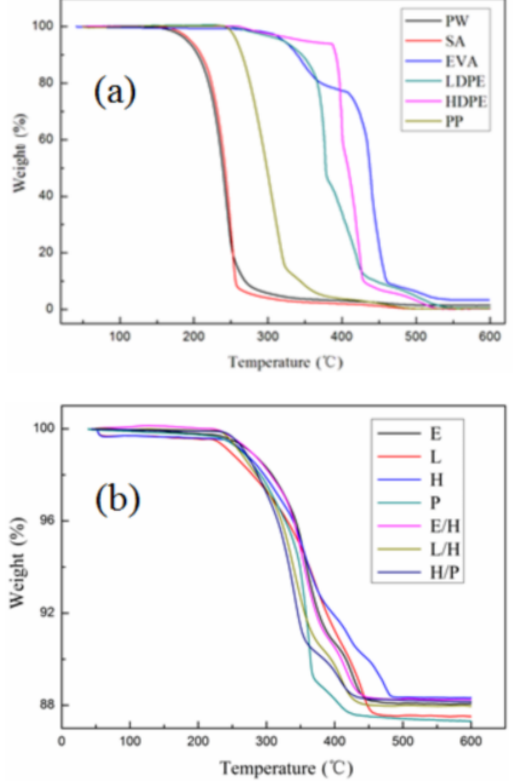
Fig. 2 TGA of (a) binder components and (b) feedstocks with various backbone